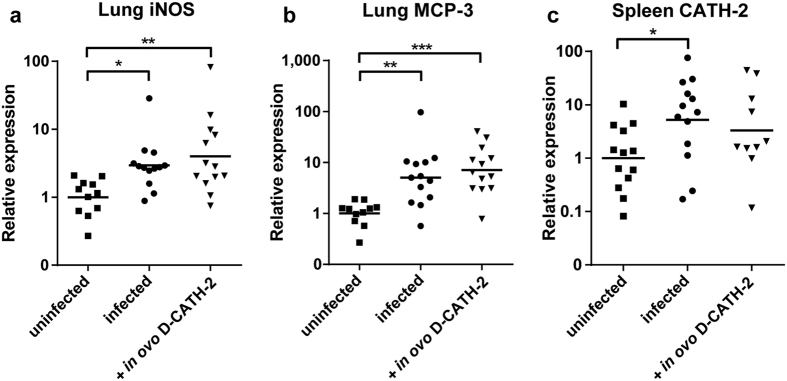
Immune related gene expression measured at 2 days post E. coli challenge by qPCR. Expression was calculated relative to the uninfected group. Geometric means are displayed. (a) iNOS in lung, (b) MCP-3 in lung, (c) CATH-2 in spleen. Data were analyzed by one-way ANOVA with a Tukey post-hoc test. *p < 0.05, **p < 0.01, ***p < 0.001.